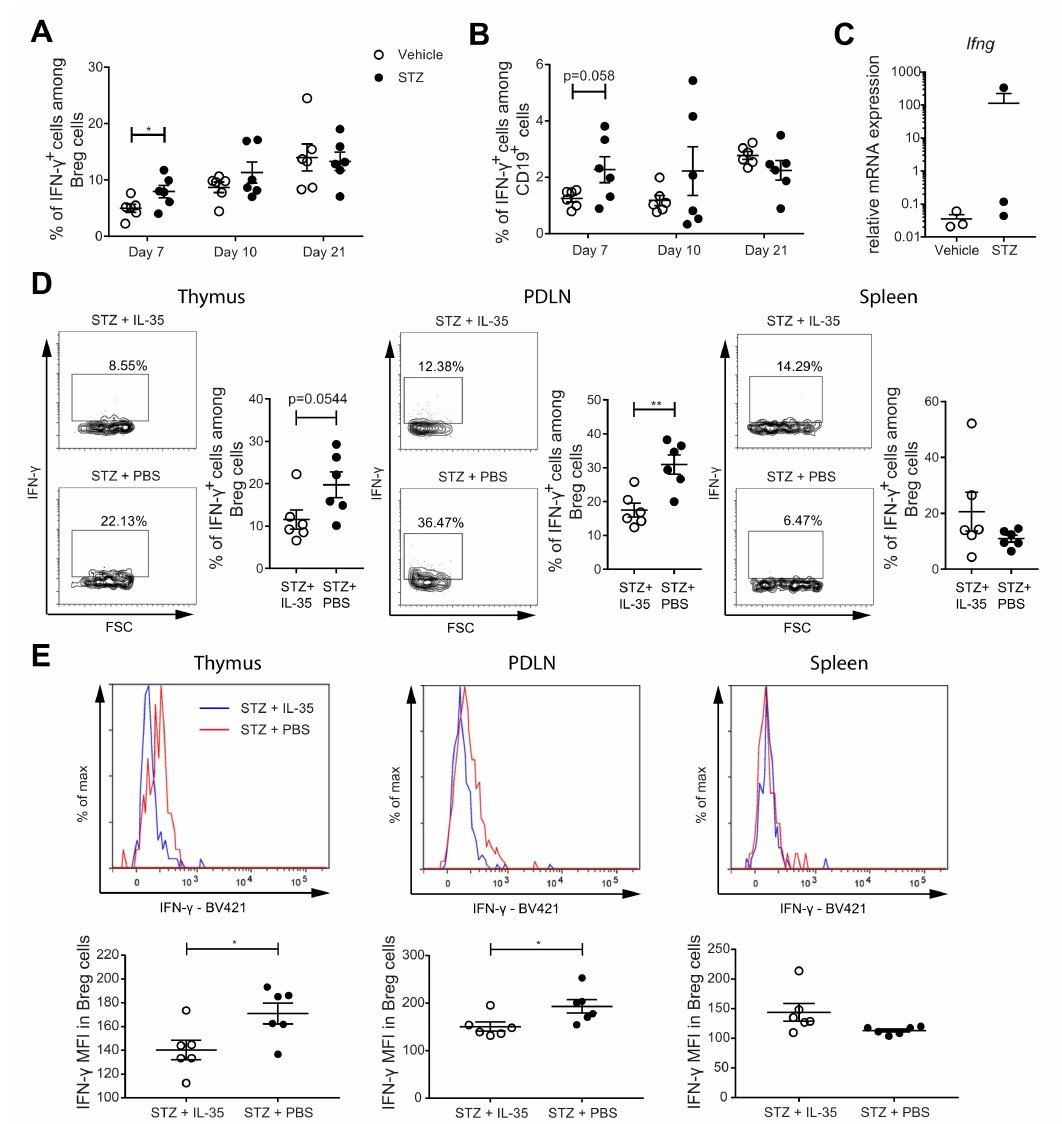
Figure 5. The proportion of IFN- γ + cells among Breg cells was increased in MLDSTZ mice, and IL-35 treatment pre- vented such an increase. Spleens of MLDSTZ mice were removed on day 21, and single cells were prepared and stained. ( A ) Proportions of IFN- γ + cells among Breg cells. ( B ) Proportions of IFN- γ + cells among CD19 + cells. Breg cells were sorted and used for subsequent qRT-PCR. ( C ) The relative mRNA expression levels of Ifng. Male CD-1 mice were injected with low doses of STZ for 5 consecutive days. The mice further received PBS or recombinant mouse IL-35 injections daily for 8 days. Single cells were prepared from removed thymic glands, PDLNs, and spleens. ( D ) Proportions of IFN- γ + cells among CD19 + CD1d + CD5 + Breg cells and representative dot plots. ( E ) The mean fluorescence intensities of IFN- γ in CD19 + CD1d + CD5 + Breg cells and representative histograms. Results are expressed as means ± SEM from one or two experiments ( n = 3 mice/group/experiment). Unpaired t -tests were performed for comparison. * and ** denote p < 0.05 and p < 0.01,